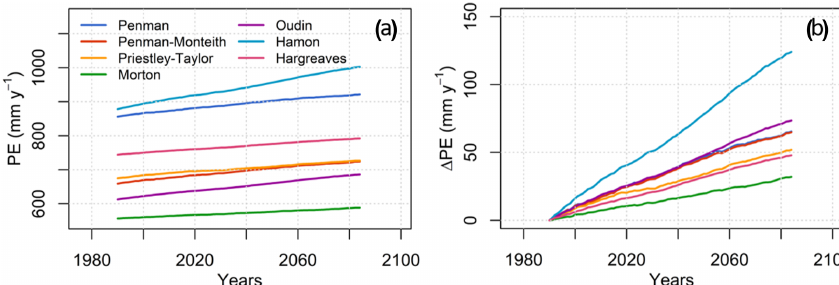
Figure 3. Projected mean annual PE (a) and expected increase (b) for each formulation. The time series are obtained by averaging the 30 RCP–GCM–RCM time series for each PE formulation. A 30-year rolling mean is applied so that, for instance, the value for the first year in the plotted time series (at year 1990) corresponds to the PE averaged over the 1976–2005 period.